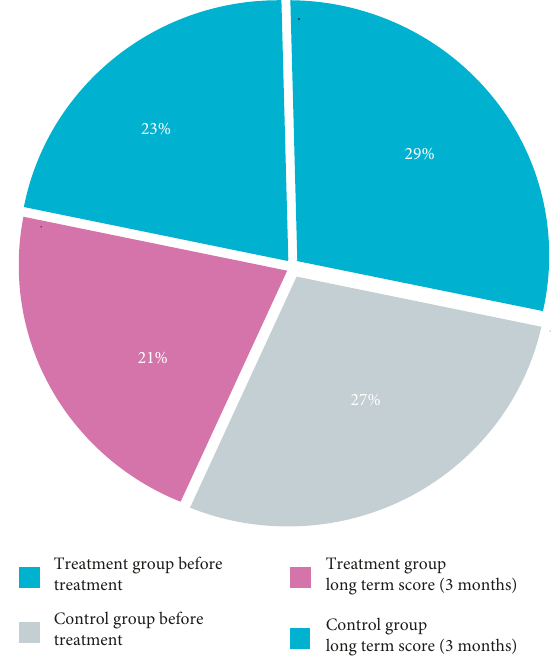
Figure 4: Comparison of visual pain scores between the two